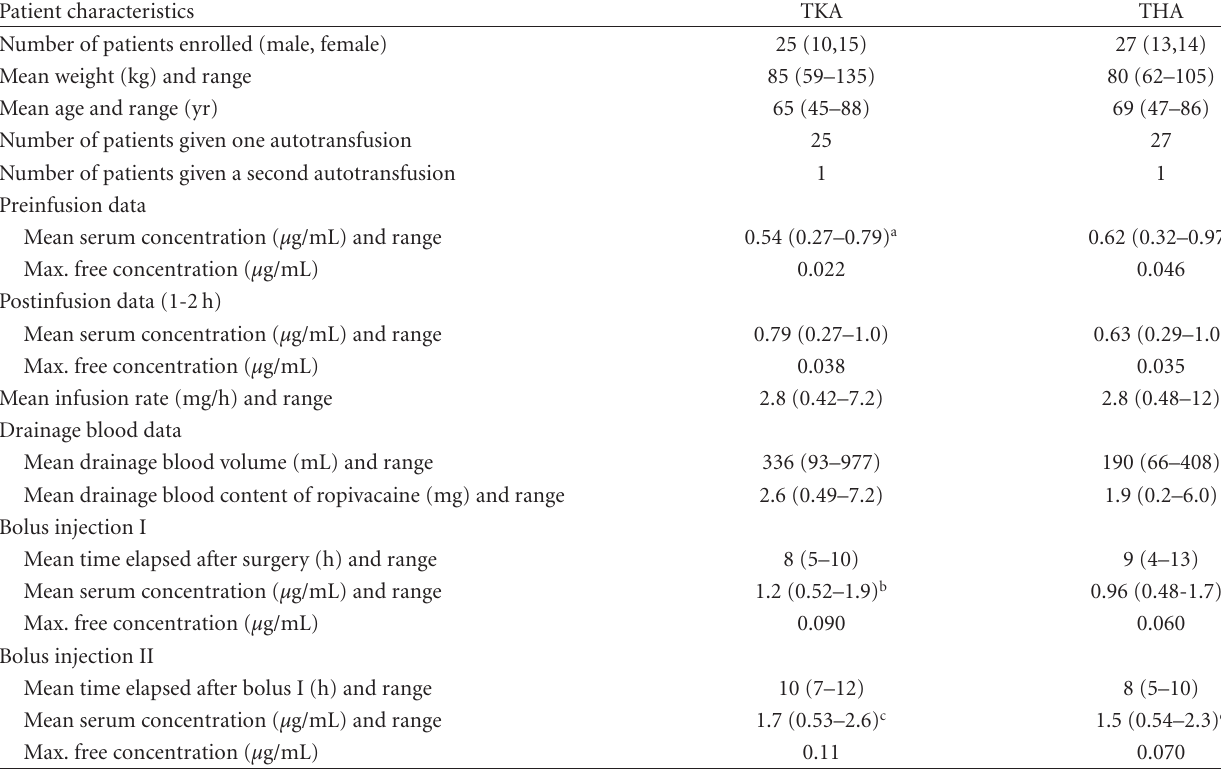
Table 1: Patient characteristics, autotransfusion, and drainage blood